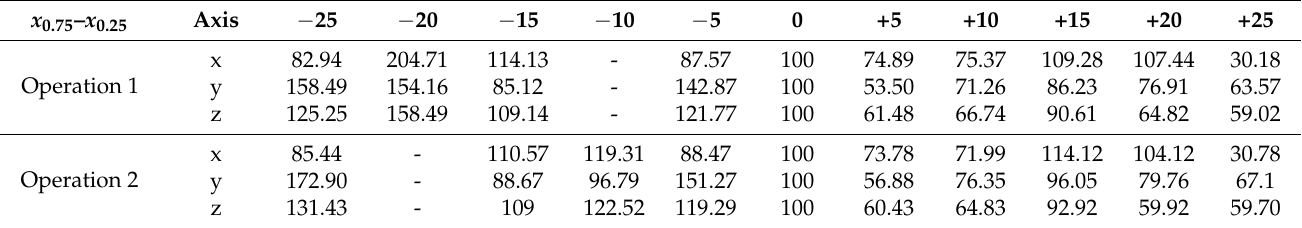
Table 6. Quarterly range percentage value x 0.75 – x 0.25